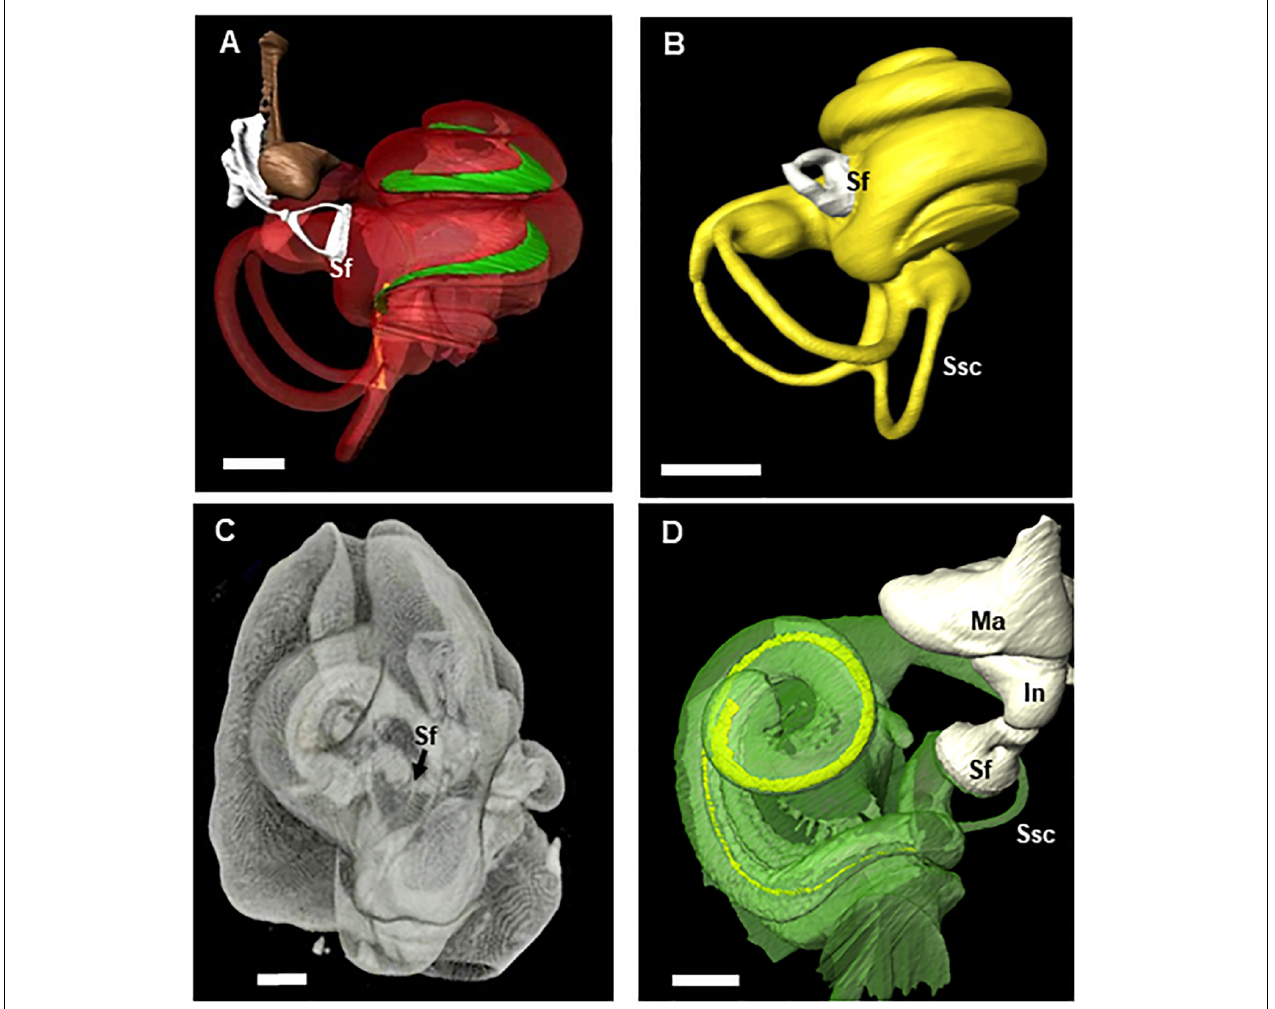
FIGURE 6 | 3D reconstruction from microCT scans of the middle ear ossicles and inner ears in two species of echolocators (big brown bat and harbor porpoise) with unusual stapes input positions. Videos ( Supplementary Videos 2, 3 ) show rotations of the cochlear canals that become transparent to reveals the path and width changes of the basilar membrane from base to apex as well as the placement of the stapes and oval window in each of these species (images and multimedia copyright© 2021 DK, all rights reserved). Sf, stapes footplate; In, incus; Ma, malleus; Ssc, semi-circular canal. Scale bar = 1 mm. (A) Eptesicus fuscus (big brown bat). 3D reconstruction using Amira of a left ear obtained from 17 micron voxel X-Tek MicroCT scan data. The cochlea has 2.25 turns. The basilar membrane (green) length is 8.7 mm and has a post-hook basal turn stapedial input (Sf) (see Supplementary Video 2 to view rotations and basilar membrane path within the cochlear capsule). (B) Pipistrellus abramus (Japanese house bat) 3D reconstruction of left ear obtained from 17 micron voxel X-Tek MicroCT scan data. The basilar membrane length is 6.8 mm with a post-hook lower basal turn stapedial input (Sf). (C) Phocoena phocoena (harbor porpoise) right ear is shown reconstructed with the periotic and cochlear walls transparent to reveal the basilar membrane (yellow) path and stapes located at end of an extended, double hook. The image was reconstructed from 100 micron voxel scans of the entire tympano-periotic complex within the head. The darkened line along the cochlear canal is the edge of the outer